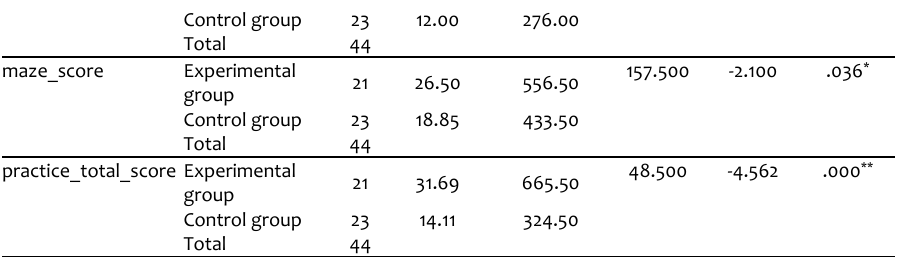
Table 8. Post-test results of the development scores in Experimental and Control groups